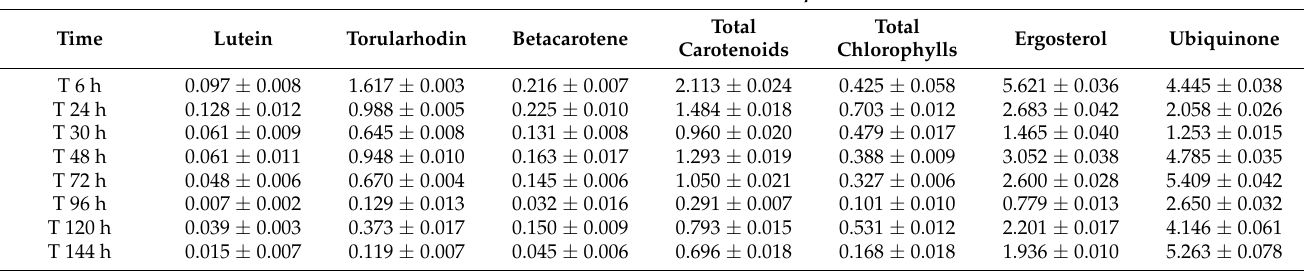
Table 3. Bioreactor co-cultivation Rhodotorula kratochvilovae + Desmodesmus sp.—production of pigments and sterols during the growth (mg/g